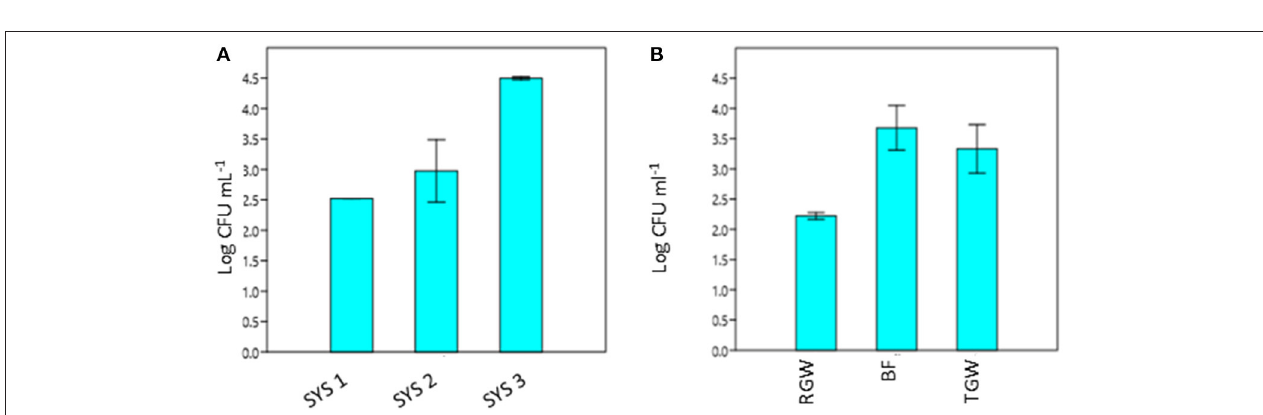
FIGURE 3 | Tetracycline-resistant bacterial count (TRBC) at 25 ◦ C from treated greywater (TGW) from the three systems (A) and in RGW, biofilm and TGW samples from the three systems (B) . RGW, raw greywater; BF, biofilm; TGW, treated greywater; Log CFU mL − 1 , tetracycline-resistant bacterial count (TRBC). Error bars indicate SD of duplicate plate counts from a single system (A) and from each sampling point (B)